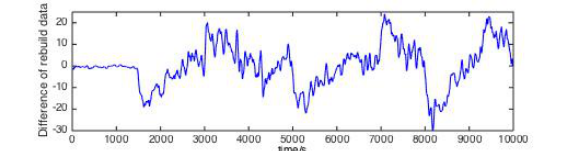
Figure 11. Differential detector result with attack.